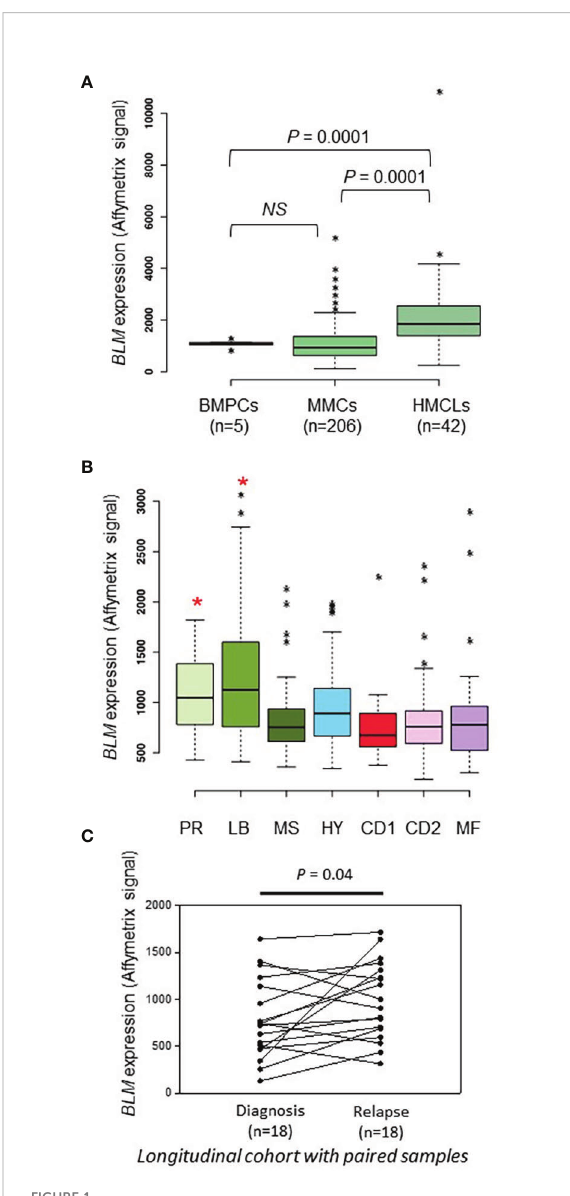
FIGURE 1 BLM expression in MM. (A) BLM expression analysis by Af fi metrix microarrays from normal BMPCs from 5 healthy donors (median: 1133; range: 863-1328), MMCs from 206 MM patients from the HM cohort (median: 935; range: 113-5206), and 42 HMCLs (median: 1848; range: 246-10901). * marks outliers. Statistical analysis used a Student ’ s t-test of paired samples. (B) Gene expression pro fi ling of MMCs of the patients of UAMS-TT2 cohort were used. Patients (n = 250) were classi fi ed in the 7 molecular groups of MM. PR: cell cycle and proliferation, LB: low bone disease, MSET: MMSET overexpression, HY: hyperdiploid signature, CDNN1: Cyclin D1 overexpression, CDNN2: Cyclin D2 overexpression, MAF: overexpression of MAF and MAFB genes. Small asterisks mark outliers in each group. Big red asterisks indicate that BLM expression is signi fi cantly higher in the group compared to all the patients of the cohort (P < 0.05) (Student ’ s t-test). (C) BLM expression is signi fi cantly higher at relapse compared to diagnosis in a longitudinal cohort of 18 paired patient ’ s samples (paired Student ’ s t-test). * p-value <